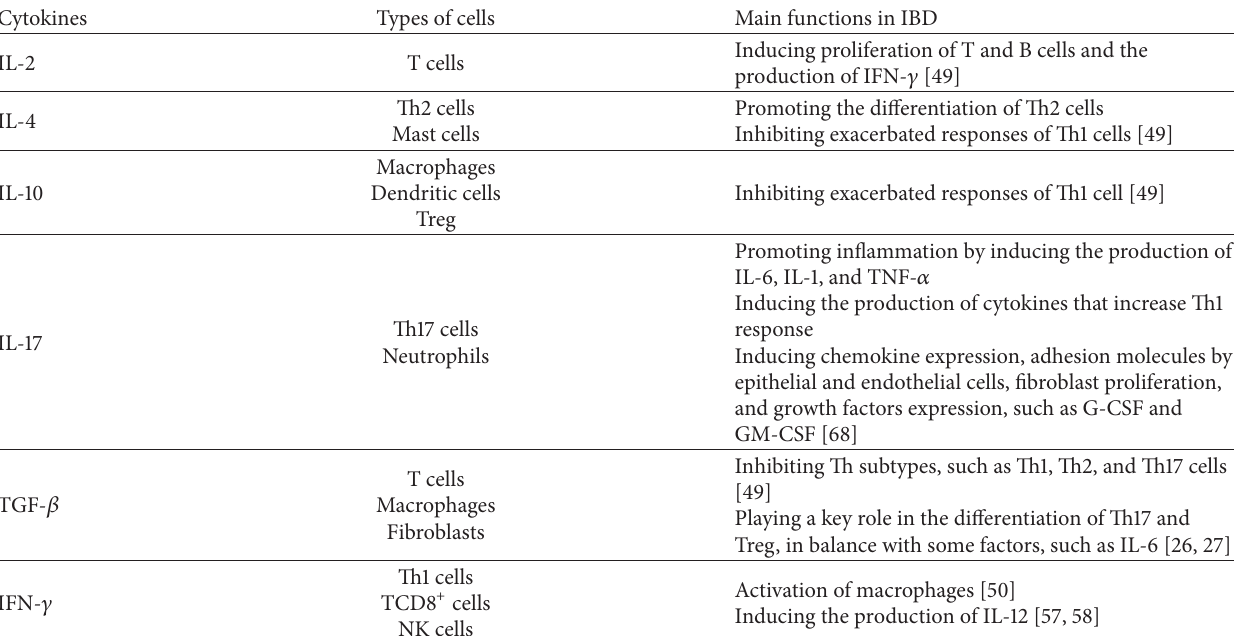
Table 2: Main cytokines of the adaptive immune response, cells that produce them, and the principle